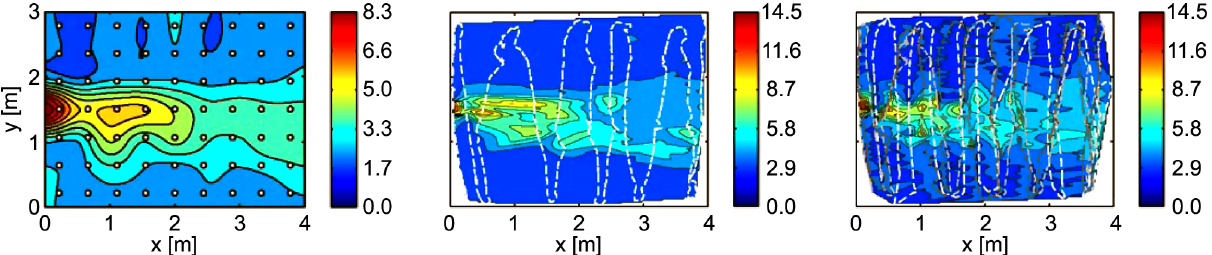
Figure 5 . Mapped gas distribution in a wind tunnel adapted from Pyk et al. [60]. The gas source